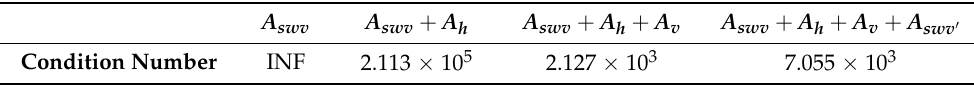
Table 7. Condition number of each coefficient matrix in the tomography solution at 12:00 UTC a.m. DOY 182,